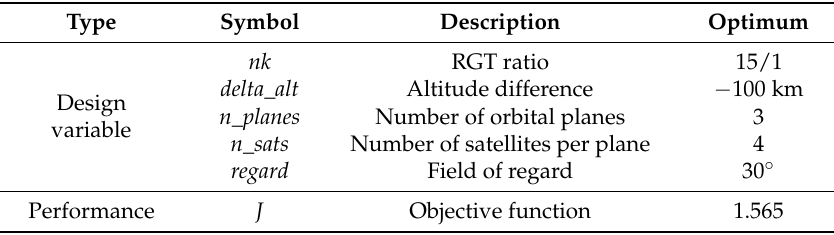
Table 18. SD optimal solution (3 planes).